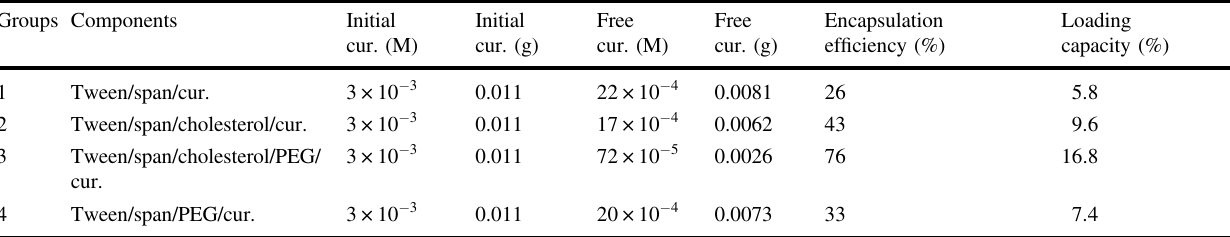
Table 2 The encapsulation ef fi ciency and loading capacity of the different formulations in this study Groups Components Initial